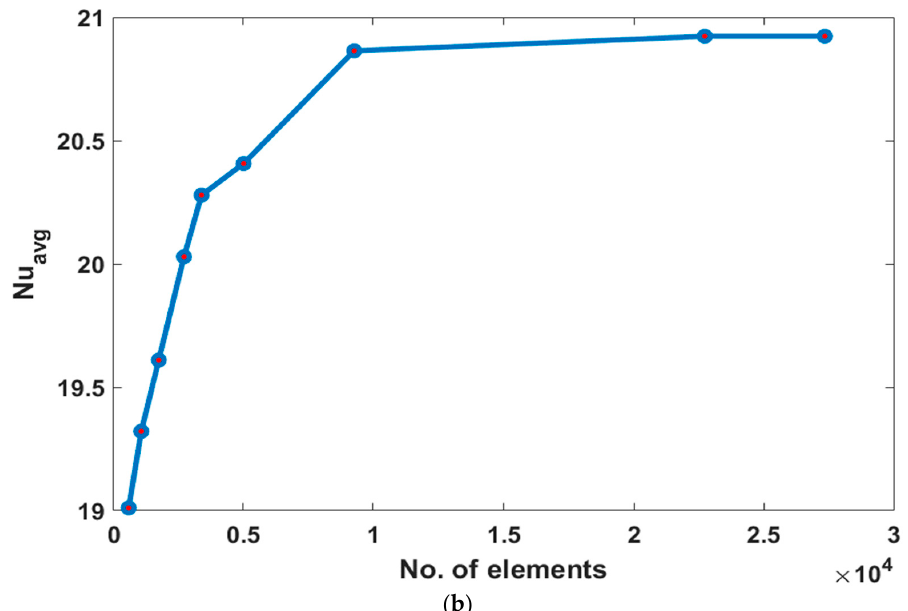
Figure 2. ( a ): A computational grid at finer level mesh. ( b ) Grid independence test.